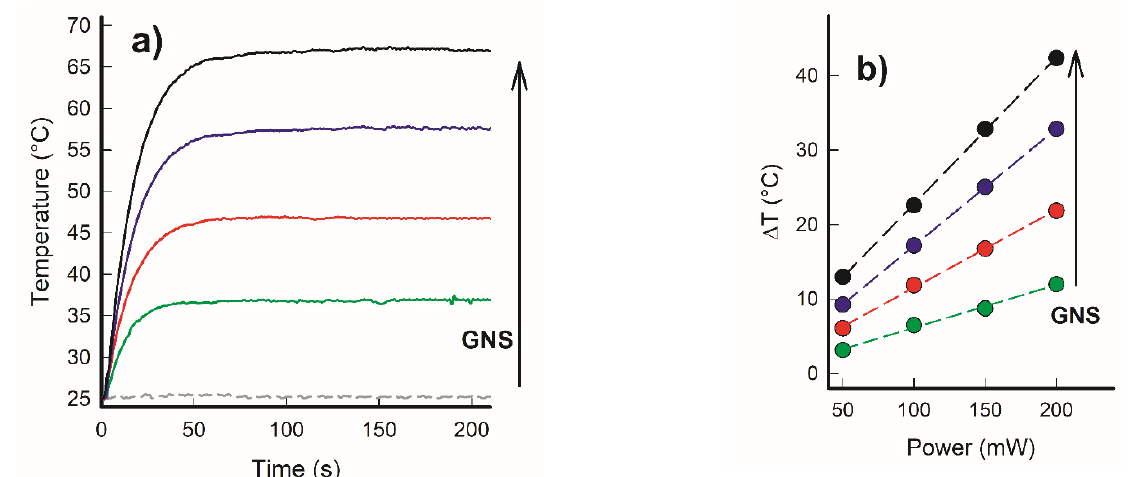
Figure 3. ( a ) Thermograms of five different PDMS samples with embedded coated GNS at increasing concentrations (0, 0.9, 1.8, 2.7, and 3.6 × 10 − 6 mol Au/g of elastomer) obtained by irradiation with an 808 nm laser at 200 mW of power (irradiance: 0.264 W/cm 2 ). ( b ) Δ T vs. applied power for PDMS samples with embedded GNS at increasing concentrations, showing a linear dependence (green: 0.9 × 10 − 6 ; red: 1.8 × 10 − 6 ; blue 2.7 × 10 − 6 ; black 3.6 × 10 − 6 mol Au/g of elastomer).